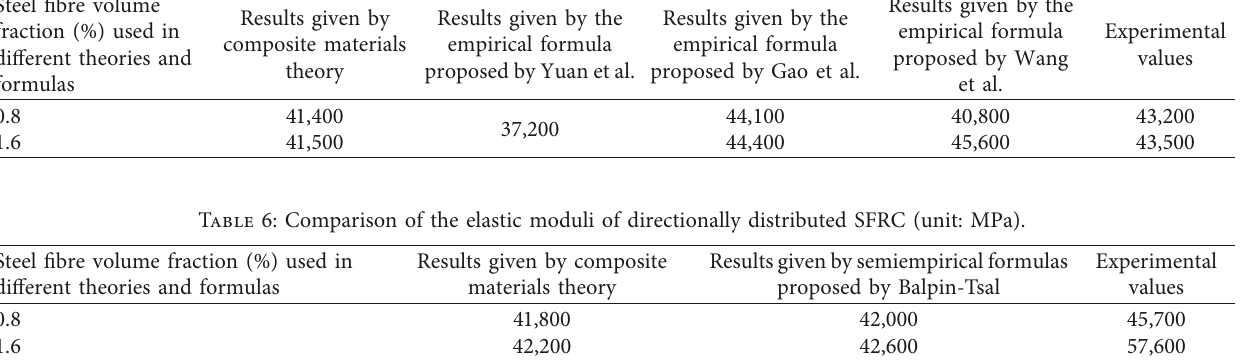
Table 5: Comparison of the elastic moduli of ordinary randomly distributed SFRC (unit: MPa). Steel fibre volume